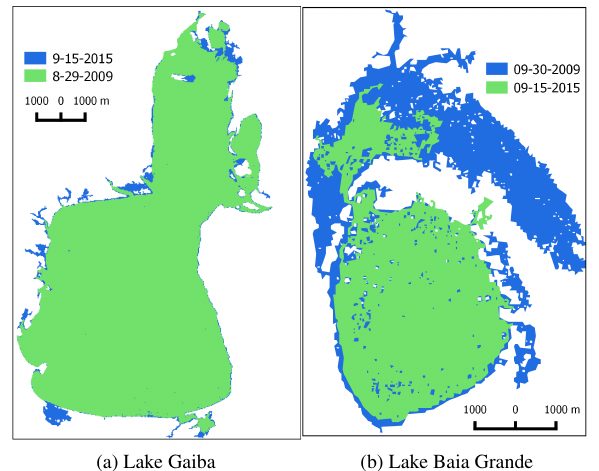
Figure 7: Comparison of some of the water surface areas cal- culated for Lake Gaiba (a) and Lake Baia Grande (b). Note that Lake Baia Grande is located in a very flat area that even the small- est increase in water level involves a large difference in area while Lake Gaiba is much less affected by water level